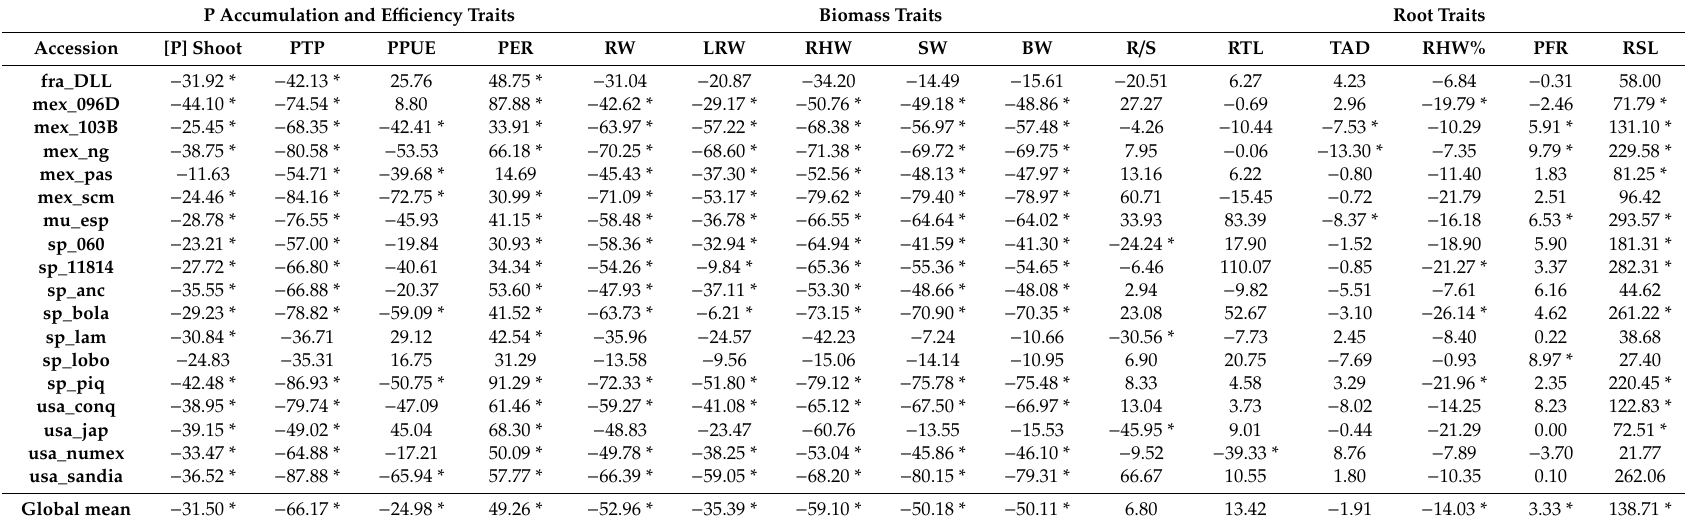
Table 4. Accession behavior given by di ff erences (%) between the control and NoP conditions for Trial 2. Twenty di ff erent P accumulation and e ffi ciency, biomass and root traits ( n = 6) and parameters were